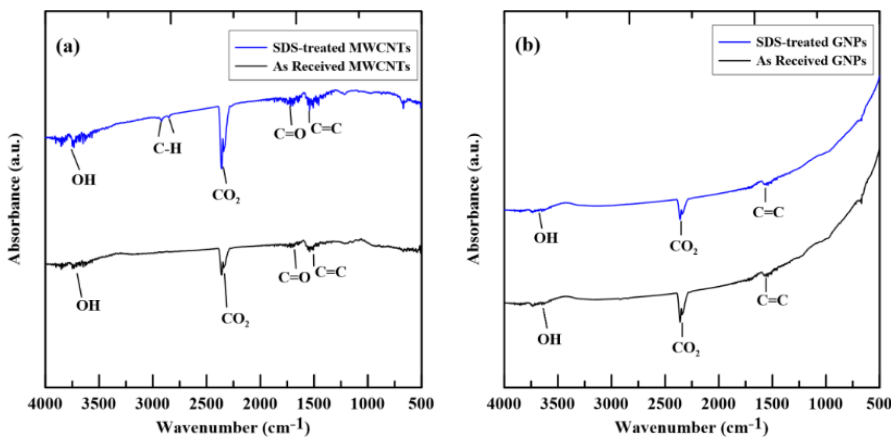
Figure 3. Comparison of the FT-IR spectra between the as-received and SDS treated carbon nano-fillers: ( a ) MWCNTs and ( b ) GNPs.